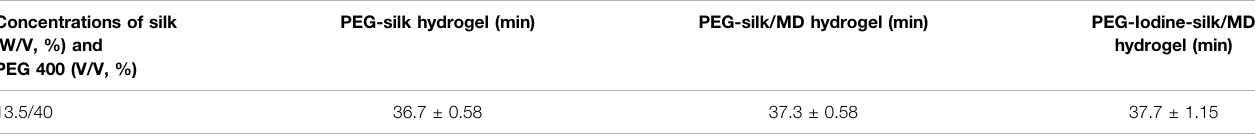
TABLE 2 | Uncon fi ned compression data for silk